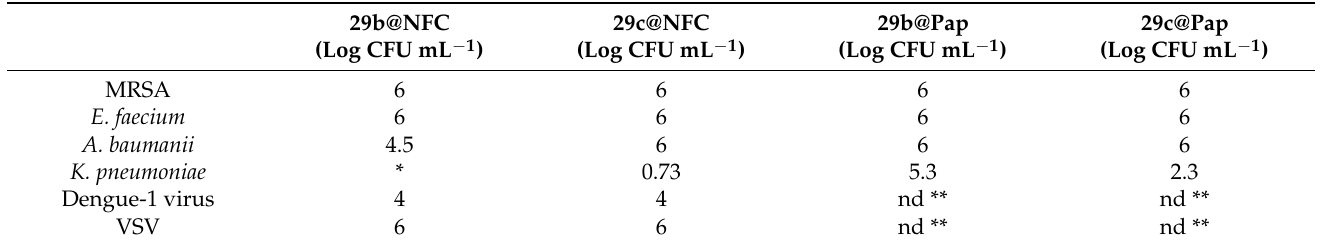
Table 1. Photodynamic antimicrobial and antiviral efficacies, of prepared materials ( 29b@NFC